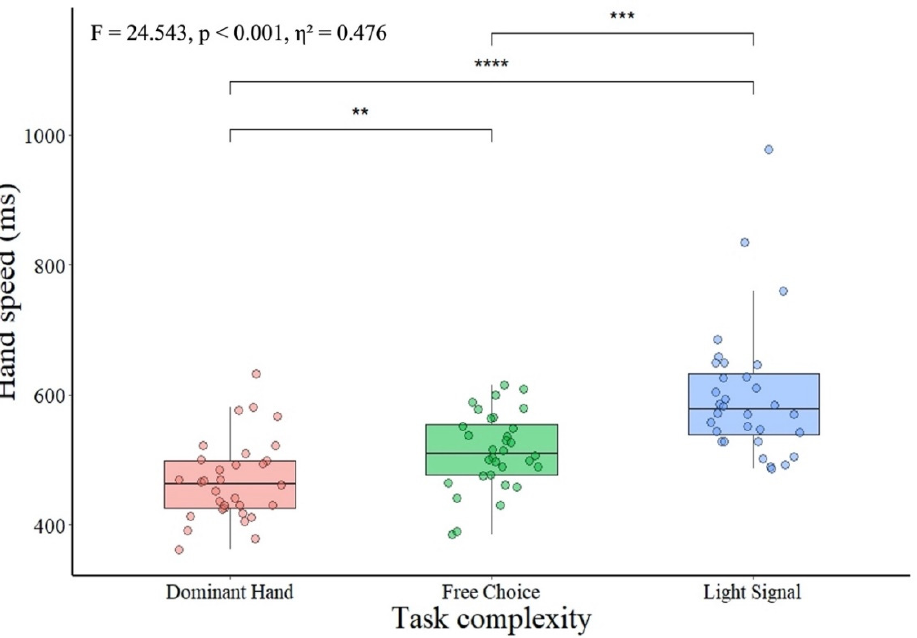
Figure 1. The hand movement response time in tasks of different complexity. Note: ** significant at p < 0.01, *** significant at p < 0.001, and **** significant at p < 0.0001. Dominant hand—response time of dominant hand on light signal; free choice—hand response time when participants were given a free choice of either dominant or non-dominant hand; light signal—hand response time on the specific light signal. With the right hand if the signal turns red and with the left limb if the signal turns blue.